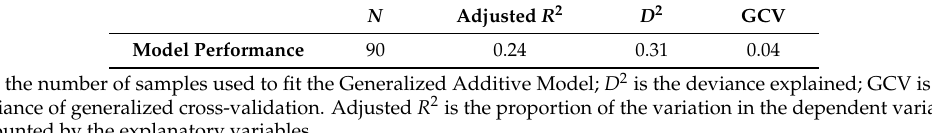
Table 4. Performance parameters of the fitted GAM between species richness and topographic variables. N Adjusted R 2 GCV